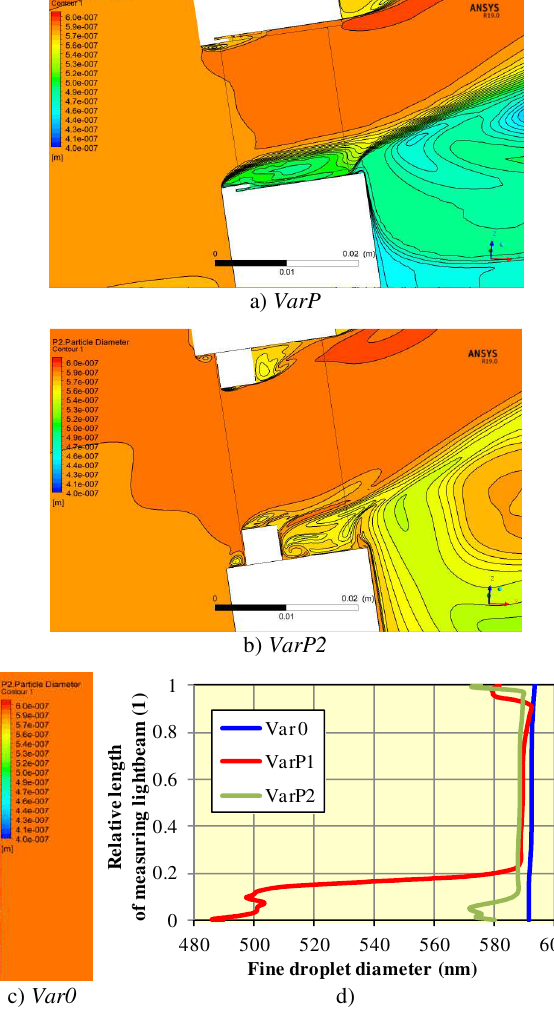
Fig. 7 . Results of the CFD simulations – fine droplet diameter, a), b), c) Contours of fine droplet diameter on the cross-section of the domain PROBE, d) Distribution of average droplet diameter along the measuring light beam.